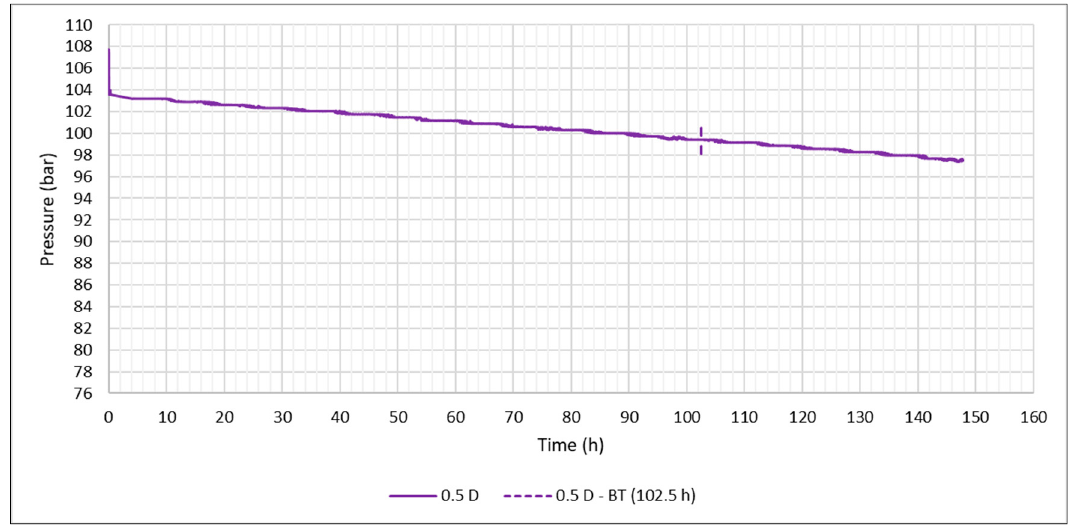
Figure 8. CO 2 pressure decay data for 0.5 D (test 4) porous media with n -decane including breakthrough (BT) time.